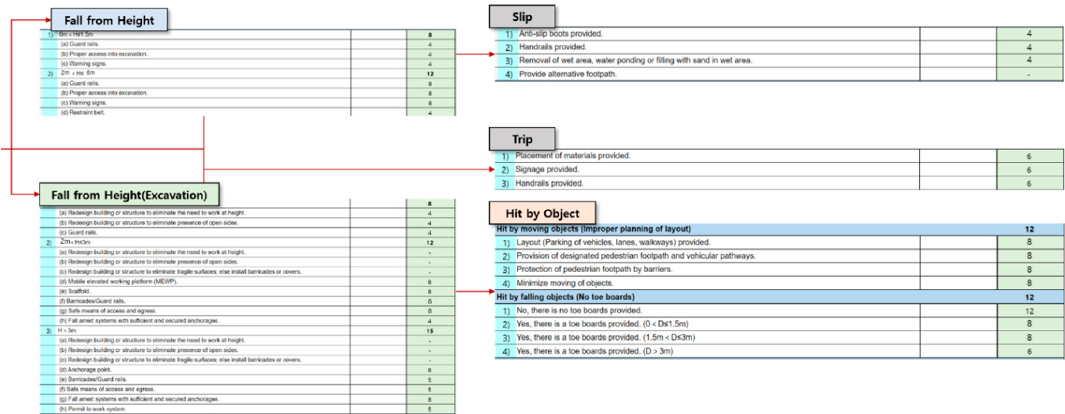
Figure 5. Results of the BIM-based risk assessment system (continue).